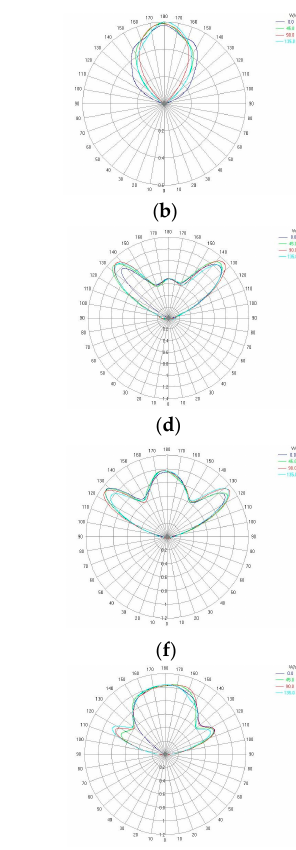
SFL_UV LED modules. ( a ) UV LED light bar; ( b ) Simulated LIDC of UV LED light bar; ( c ) Simulated